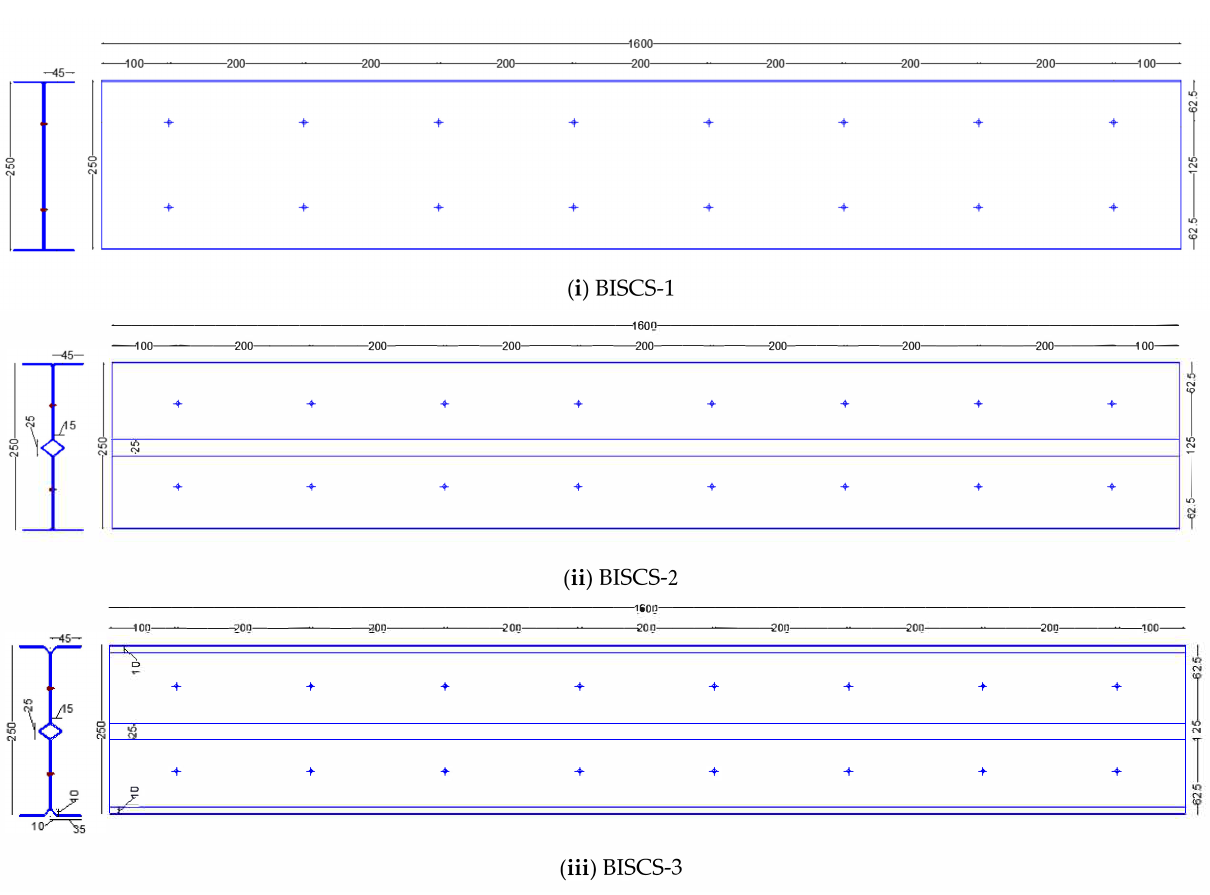
Figure 3. Details of the stiffener dimensions.